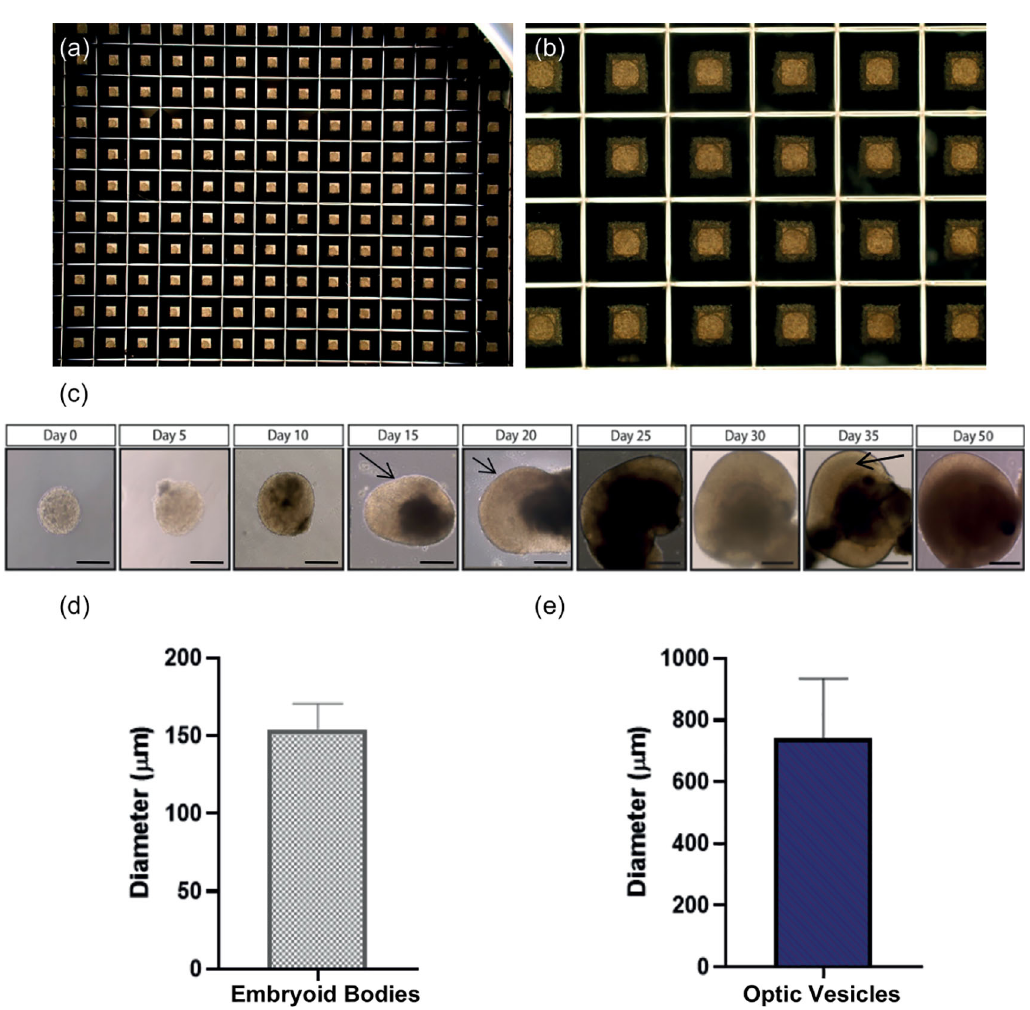
Figure 2. Embryoid bodies formed in Aggrewell ™ plates. (a-b) Uniform embryoid bodies formed in Aggrewell ™ plates after two days culture in mTeSR Plus with Y-27632 photographed at 2 (cid:1) and 10 (cid:1) magnification. (c) Brightfield images of differentiating optic vesicles from embryoid bodies at day 2 to laminated optic vesicles at day 35. At day 15, arrows indicate developing neuroepithelium. At day 20, arrows indicate initial lamination detected in optic vesicles. At day 35, arrows indicate complete laminar neuroepithelium comprised of retinal progenitor cells. Scale bar represents 150 μ m. (d) Average diameter of embryoid bodies formed at day 2 (n=3 replicate rounds of 60 embryoid bodies). Error bars represent standard deviation. (e) Average diameter of optic vesicles measured at day 35. (n=3 replicate rounds of 60 embryoid bodies). Error bars represent standard